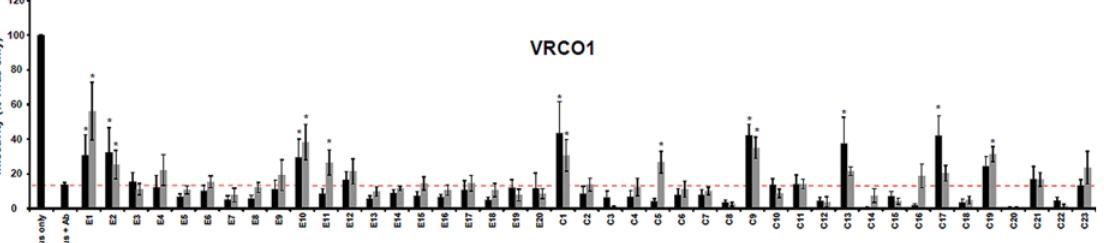
Fig 3. Inhibition of virus-neutralizing activity of monoclonal antibody VRC01 by synthesized peptides. The luciferase activity from virus-only infection was set to 100%. Red dashed line denotes luciferase activity produced by virus with the addition of VRC01 (IC90 = 6.26 μ g/ml) without peptides. Black columns correspond to 1:5000 antibody to peptide ratio, grey columns correspond to 1:1000 antibody to peptide ratio). Asterisk indicates statistical significance from the virus/VRC01 control (p (cid:1) 0.05).